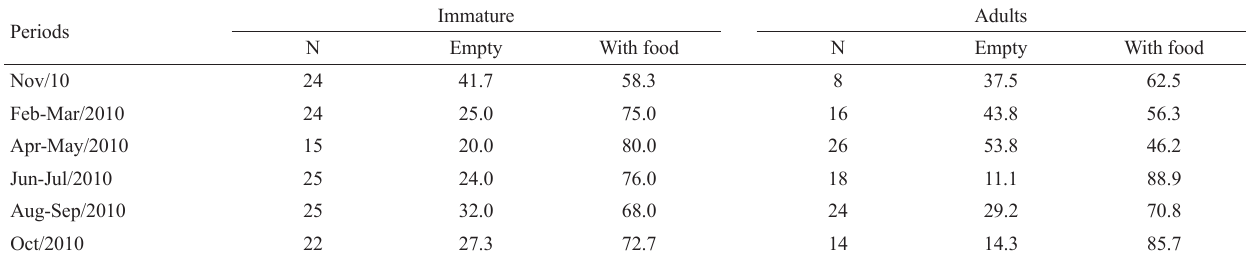
Table 1. Feeding activity of immature and adult Cichla piquiti , measured as the percentage of empty stomachs and stomachs with food (fullness categories combined, 1 to 3) over periods. N = number of stomachs